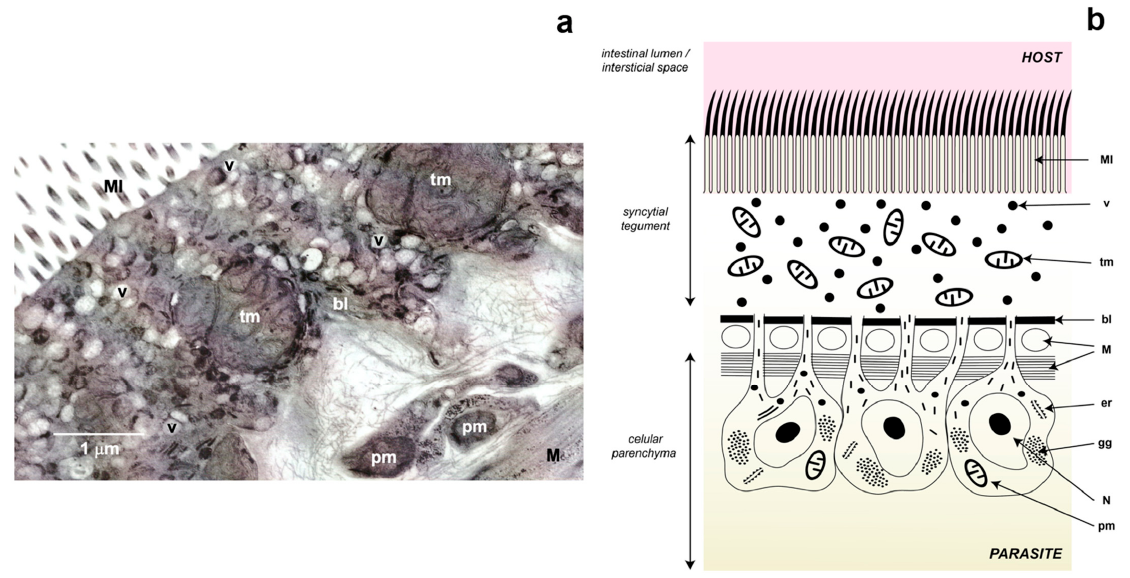
Figure 3. Tegument of the cestodes. Panel ( a ) represents a photograph of the tegument of Taenia crassiceps cysticercus obtained by transmission electron microscopy. Panel ( b ) is a schematic representation of the tegument of cestodes. Abbreviations : bl, basal lamina; er, endoplasmatic reticulum; gg, glycogen granules; M, muscle; MI, microtriches; N, nucleus; pm, parenchymal mitochondria (anaerobic mitochondria); tm, tegumental mitochondria (aerobic mitochondria); v, vesicles. In the case of the phylum Platyhelminthes, due to their flattened morphology, gas exchange as well as nutrient uptake can take place through the body wall because these